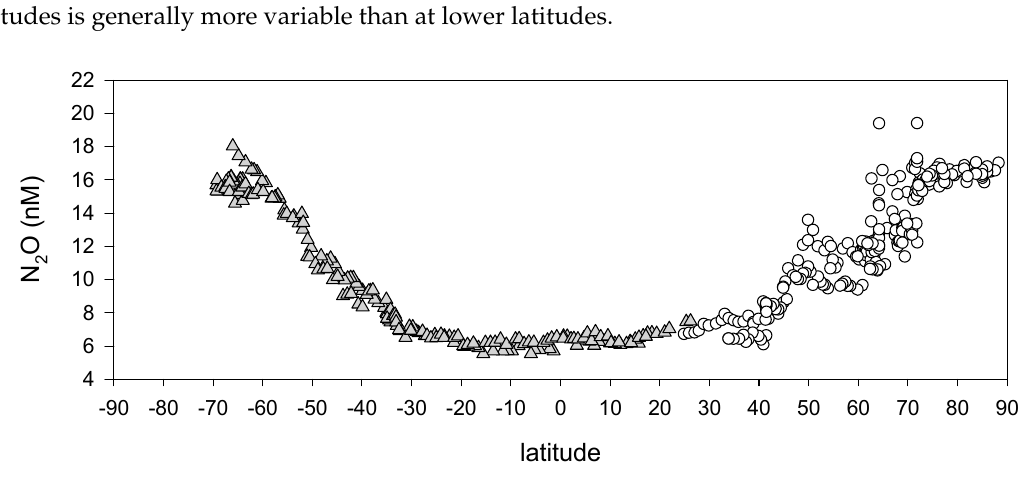
Figure 2. The distribution patterns of the 4th Chinese National Arctic Research Expedition (empty circles) and the 27th Chinese Antarctic Research Expedition (gray triangles). High concentrations and relatively low concentrations of N 2 O were observed at high latitudes and low latitudes, respectively.